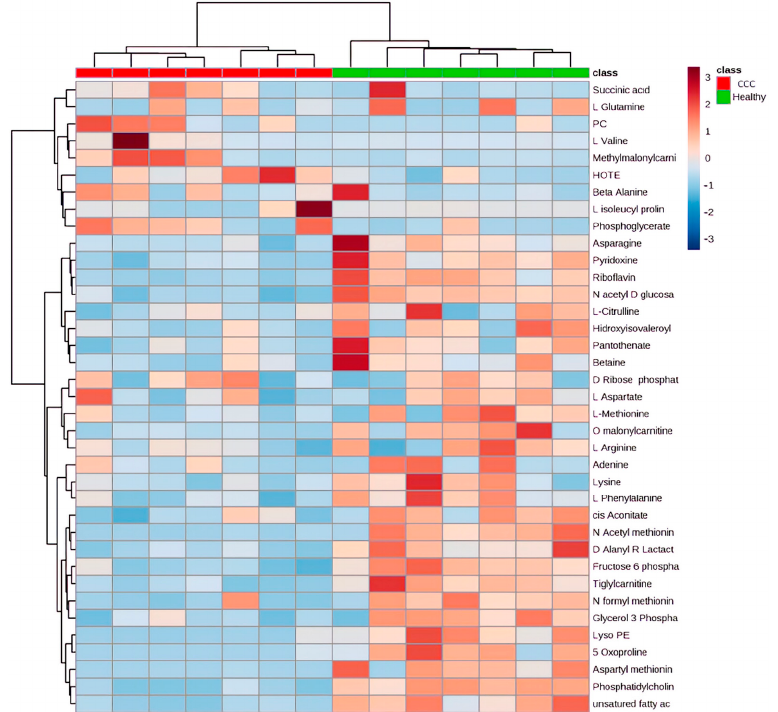
Figure 3. Hierarchical Clustering Heatmap of significantly and differentially abundant metabolites between CCC and Healthy donors. Columns correspond to samples and rows to individual metabo- lites. The color scale indicates the relative abundance of metabolites: red being the most abundant and blue the less abundant metabolites.